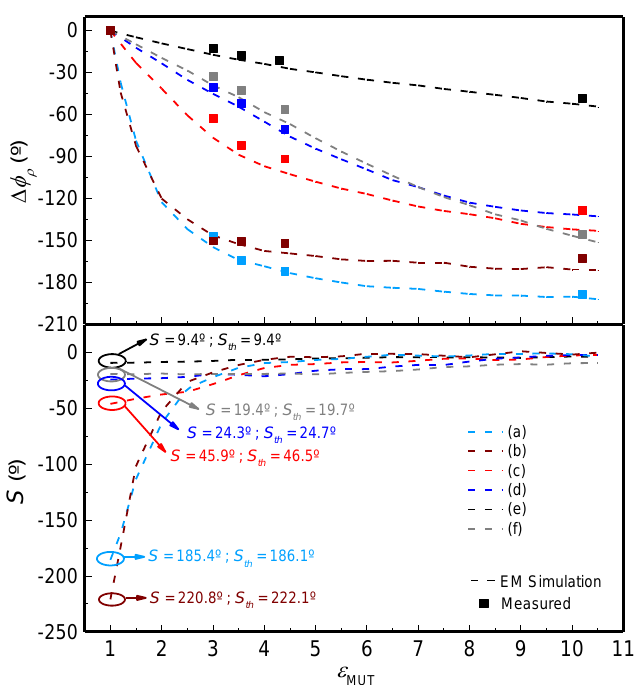
Figure 10. Measured and simulated phase of the reflection coefficient for the sensors of Figure 9, and simulated sensitivity. ( a ) Sensor with step-impedance discontinuity and Z < Z 0 < Z s ; ( b ) sensor and simulated sensitivity. ( a ) Sensor with step-impedance discontinuity and Z < Z 0 < Z s ; ( b ) sensor with step-impedance discontinuity and Z > Z 0 > Z s ; ( c ) sensor with uniform mismatched sensing with step-impedance discontinuity and Z > Z 0 > Z s ; ( c ) sensor with uniform mismatched sensing line and Z s > Z 0 ; ( d ) sensor with uniform mismatched sensing line and Z s < Z 0 ; ( e ) sensor based on line and Z s > Z 0 ; ( d ) sensor with uniform mismatched sensing line and Z s < Z 0 ; ( e ) sensor based a 90° uniform 50 Ω sensing line and ( f ), sensor based on a 180 o uniform 50 Ω sensing line. The on a 90 ◦ uniform 50 Ω sensing line and ( f ), sensor based on a 180 o uniform 50 Ω sensing line. The measured dielectric loads are 3 mm slabs of uncoated PLA ( ɛ MUT = 3), Rogers RO4003C ( ɛ MUT = measured dielectric loads are 3 mm slabs of uncoated PLA ( ε MUT = 3), Rogers RO4003C ( ε MUT = 3.55), 3.55), FR4 ( ɛ MUT = 4.4) and Rogers RO3010 ( ɛ MUT = 10.2) substrates . The sensitivities in the limit of FR4 ( ε MUT = 4.4) and Rogers RO3010 ( ε MUT = 10.2) substrates. The sensitivities in the limit of small small perturbations are given in absolute value. Reprinted with permission from [62]. perturbations are given in absolute value. Reprinted with permission from